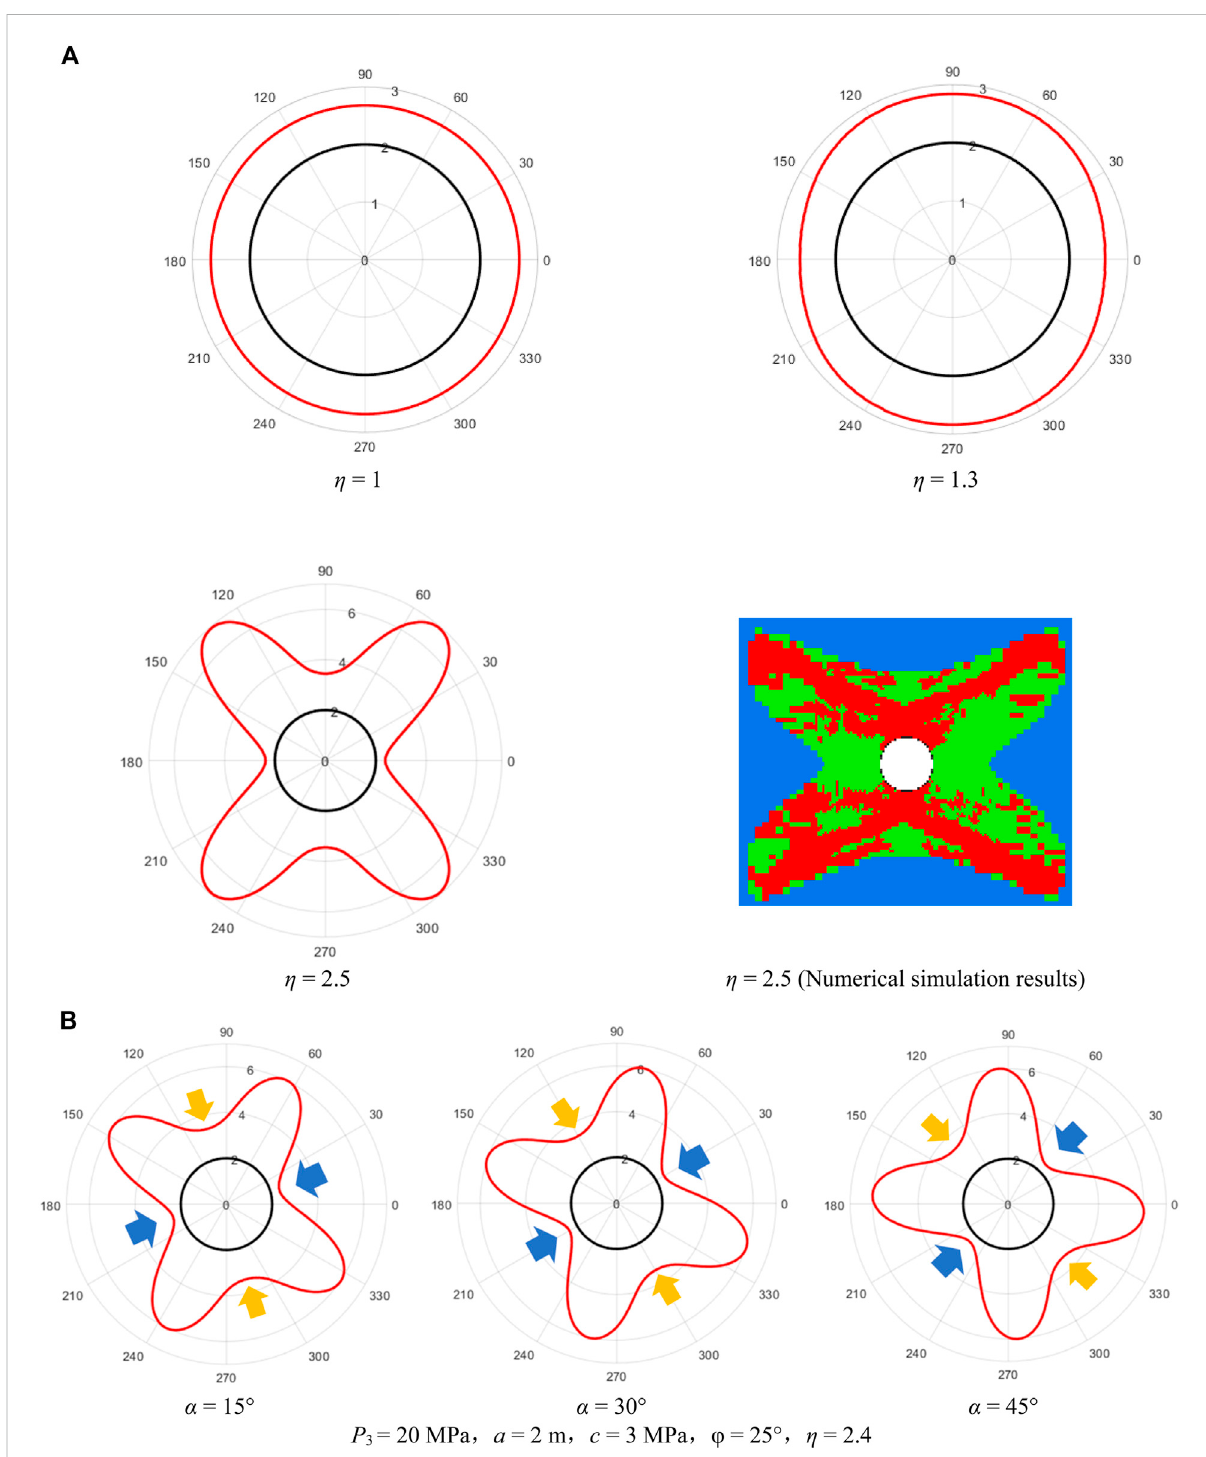
FIGURE 5 Plasticzoneshapeofthesurroundingrock. (A) Shapeoftheplasticzoneunderdifferentlateralpressurecoef fi cients. (B) Rotationofthebutter fl y plastic